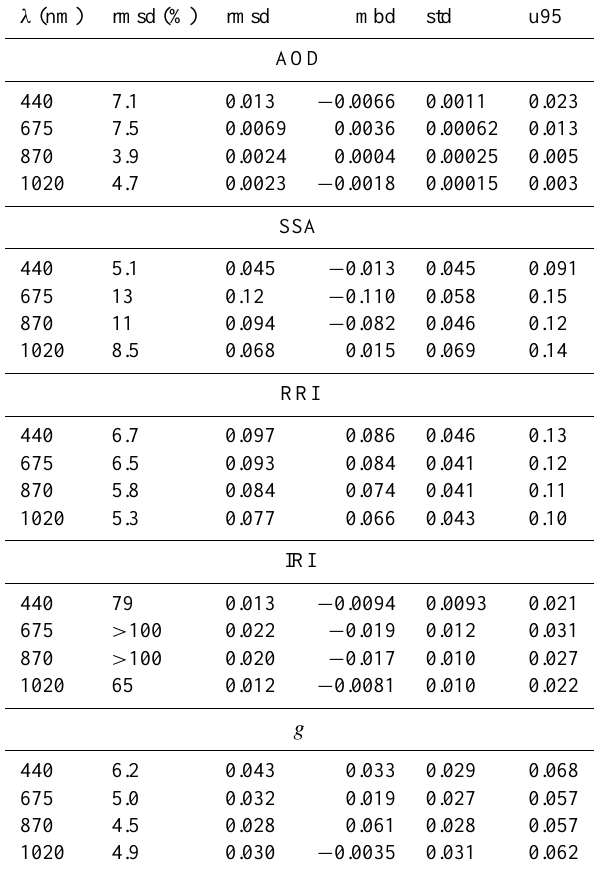
Table 1. Statistics of the differences between AERONET and SKYRAD properties. The number of data samples is